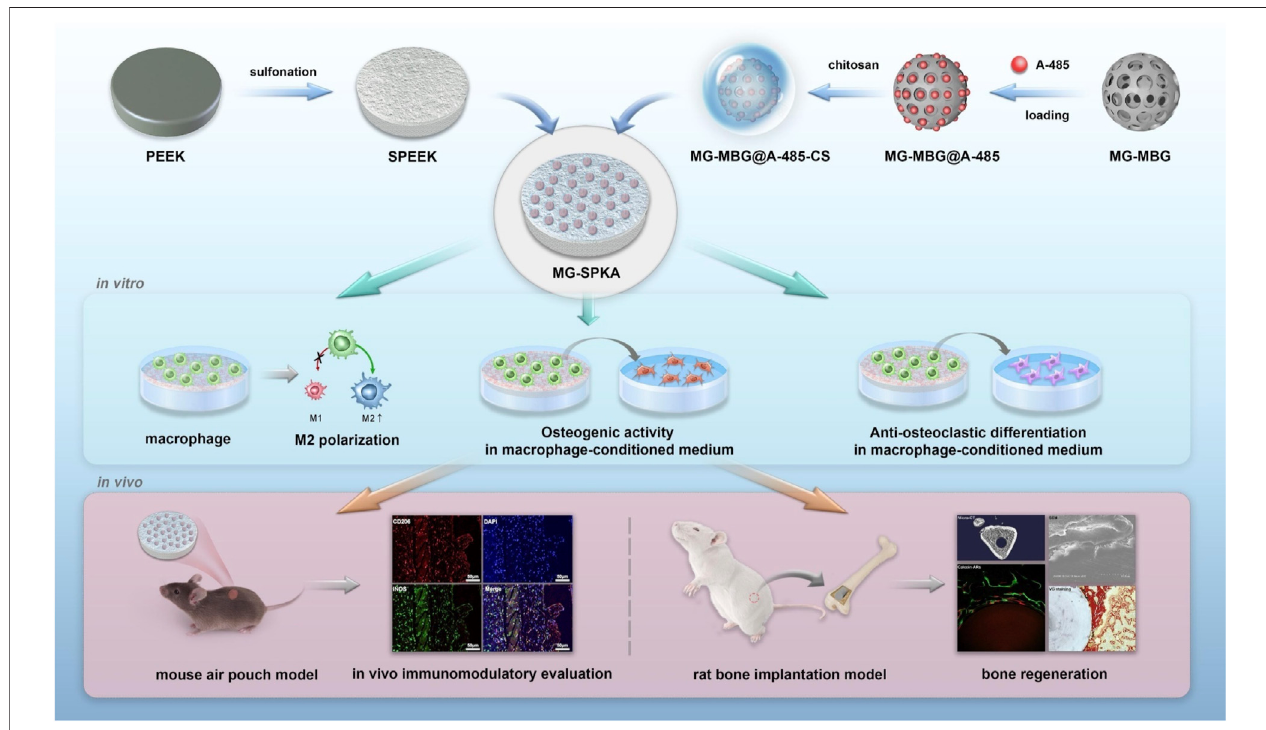
FIGURE 3 | Schematic diagram of the process used to prepare and evaluate the PEEK materials. Reproduced from Huo et al (2021c). Copyright (2021), with permission from Elsevier.